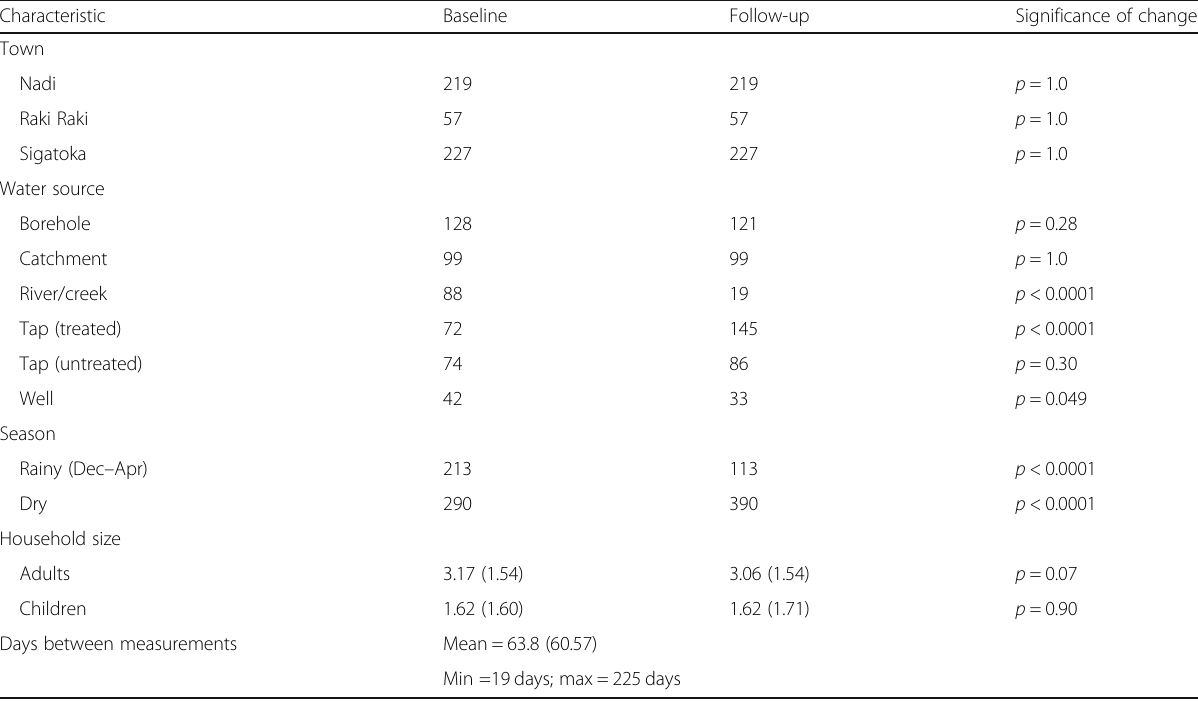
Table 1 Characteristics of the